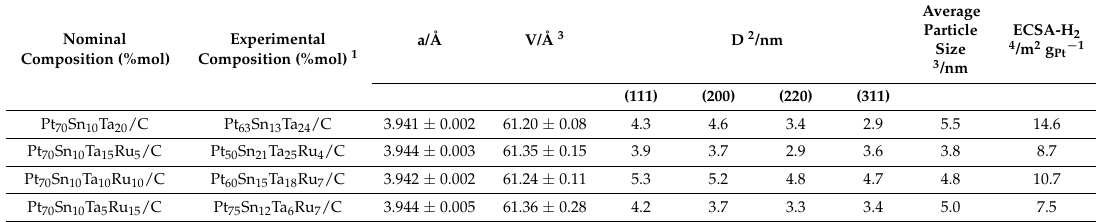
1 Results obtained by EDX; 2 Crystallite size calculated for each diffraction plane obtained by XRD; 3 Average particle sizes obtained by TEM; 4 ECSA calculated from the area of hydrogen obtained by cyclic voltammetry in an acidic